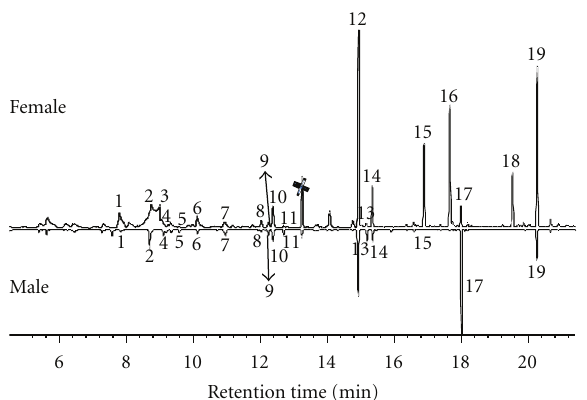
Figure 1: Gas chromatogram profile of an air-entrainment extract of males and females of Neomegalotomus parvus . (1) Camphene, (2) 6-methy-5-hepten-2-one, (3) hexanoic acid, (4) butyl butanoate, (5) hexyl acetate, (6) limonene, (7) ( E )-2-octen-1-ol, (8) pentyl butanoate, (9) undecane, (10) nonanal, (11) unknown compound, (12) hexyl butanoate, (13) dodecane, (14) decanal, (15) 4-meth- ylhexyl-butanoate, (16) hexyl pentanoate, (17) tridecane, (18) 4- methylhexyl-pentanoate, and (19) hexyl